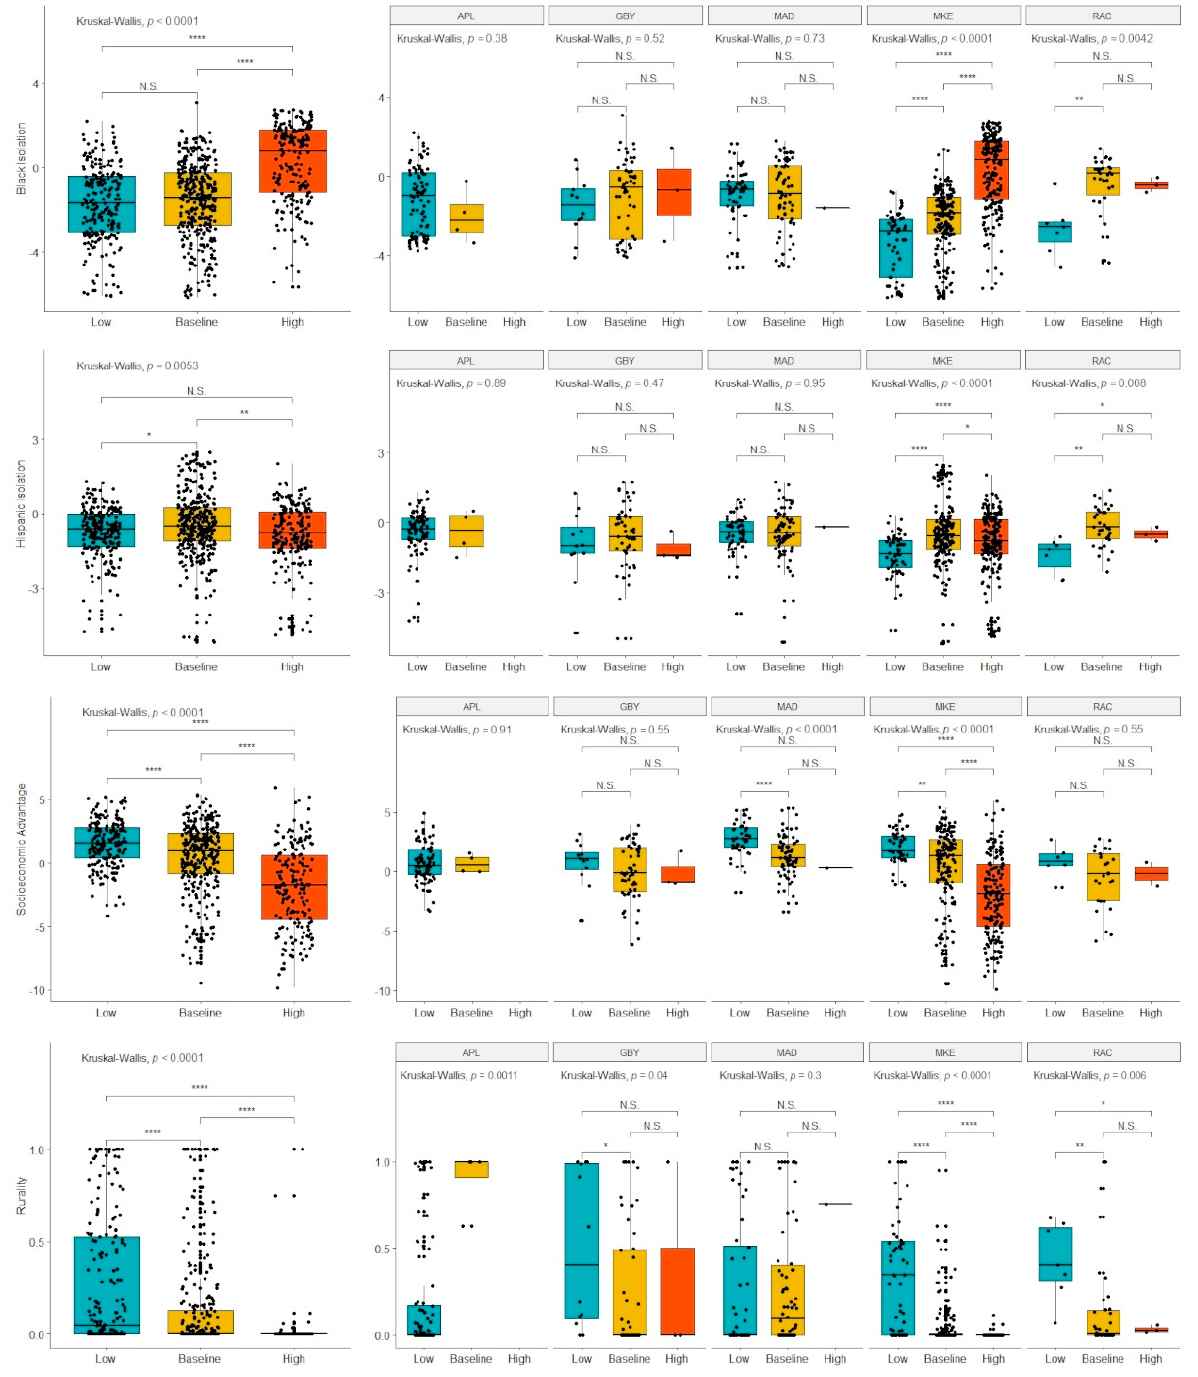
Figure 3. Boxplots comparing segregation and other demographic variables within high-, baseline-, and low-mortality tracts. The left-most column indicates comparison pooling all five MSAs (APL: Appleton, GBY: Green Bay, MAD: Madison, MKE: Milwaukee, RAC: Racine). The columns on the right-hand side show comparisons within each individual MSA. Statistical significance was assessed using the Kruskal–Wallis test. The p -values were adjusted for multiple comparisons with Benjamini–Hochberg correction for MSA-specific testing. * indicates p < 0.05, ** indicates p < 0.01, *** indicates p < 0.001, **** indicates p < 0.0001. Abbreviation: N.S.: Not Significant.